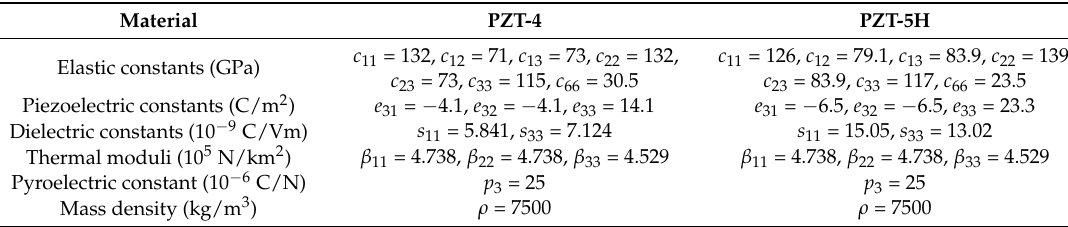
Table 5. Material properties of PZT-4 and PZT-5H [31,55].